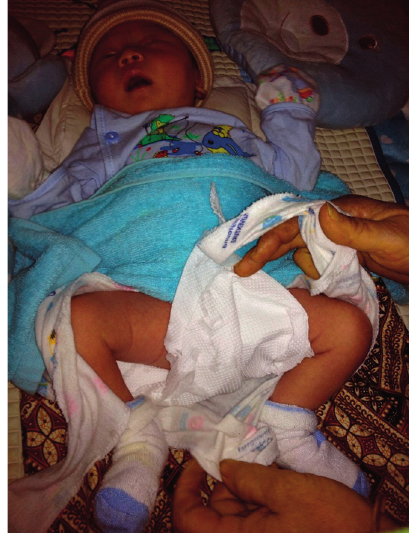
Figure 4. Diapering of a